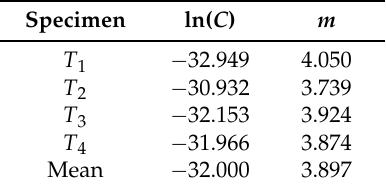
Table 2. The material parameters calculated from the specimens T 1 – T 4 .